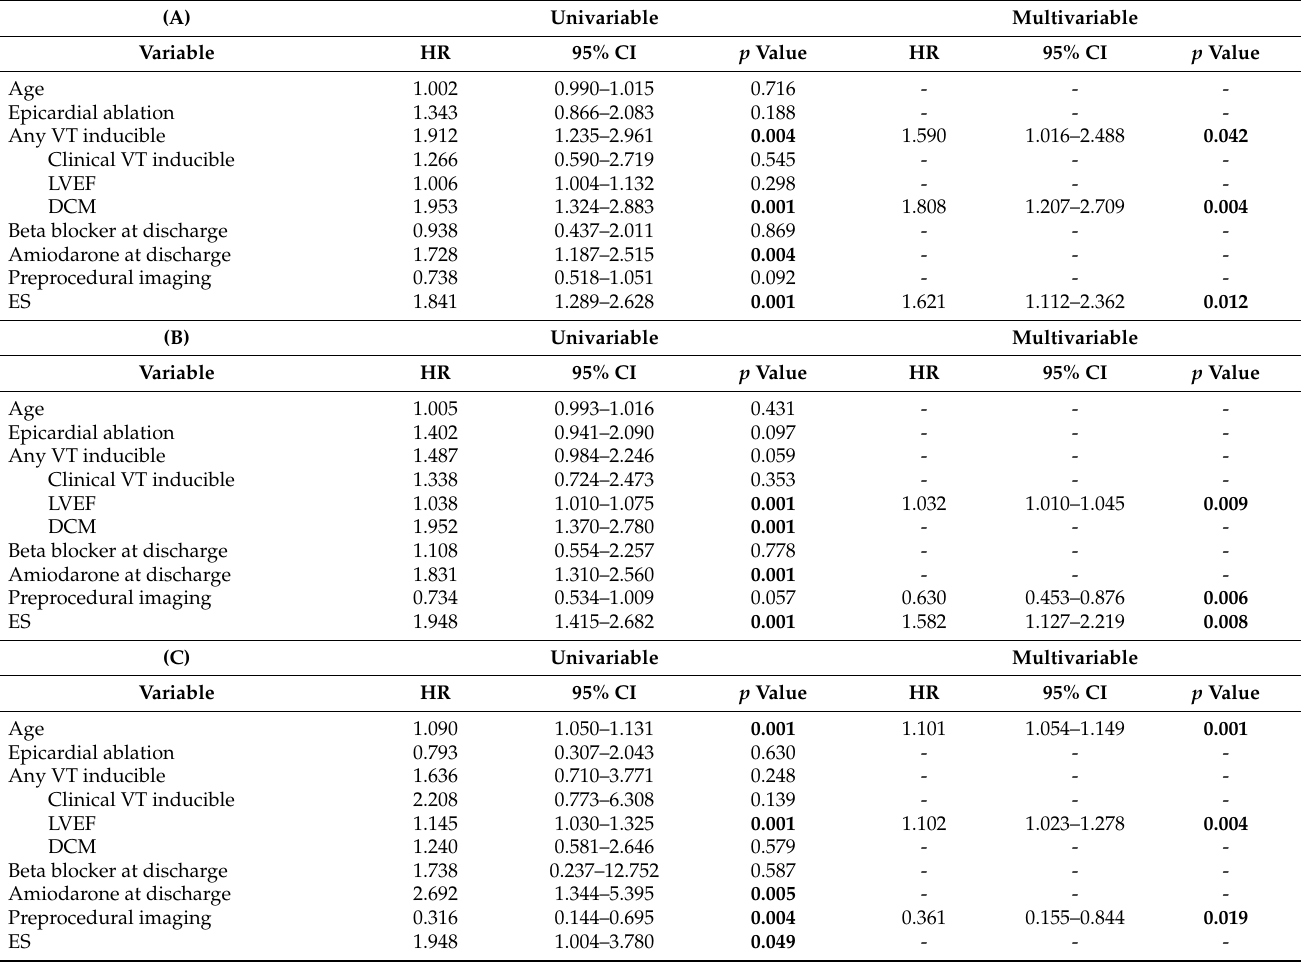
Table 5. (A) Multivariable Cox regression for VT recurrences. (B) Uni- and multivariable Cox regres- sion for rehospitalization. (C) Multivariable Cox regression for long-term cardiovascular